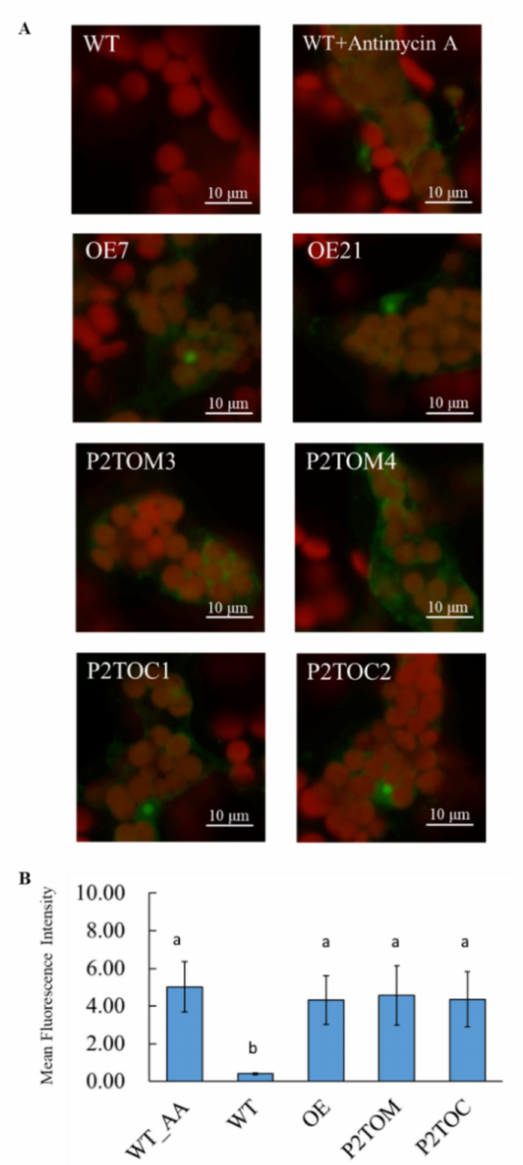
Figure 2. Confocal images of MitoSOX Red in WT and AtPAP2 OE lines. ( A ) MitoSOX Red probe was applied to peeled lower epidermis leaves from 20-day-old plants. Fluorescence of MitoSOX Red (565– 615 nm) and autofluorescence of chloroplasts (>650 nm) are shown in green and red pseudocolors, respectively. WT treated with antimycin A and untreated WT were positive and negative controls, respectively. White scale bar indicates 10 µ m. ( B ) Mean fluorescence intensity of WT (treated with AA), WT, OE7, P2TOM, and P2TOC lines was analyzed by one-way ANOVA with Tukey’s HSD test using PASW Statistics 18 software. Different letters (a, b) above each bar ( n = 4) represent significant differences ( p <